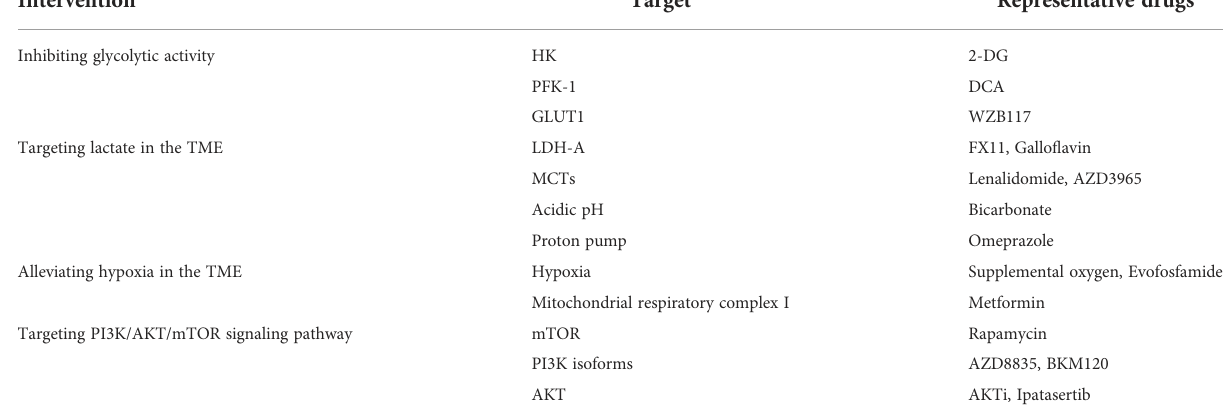
TABLE 1 Potential targets for modulating glucose